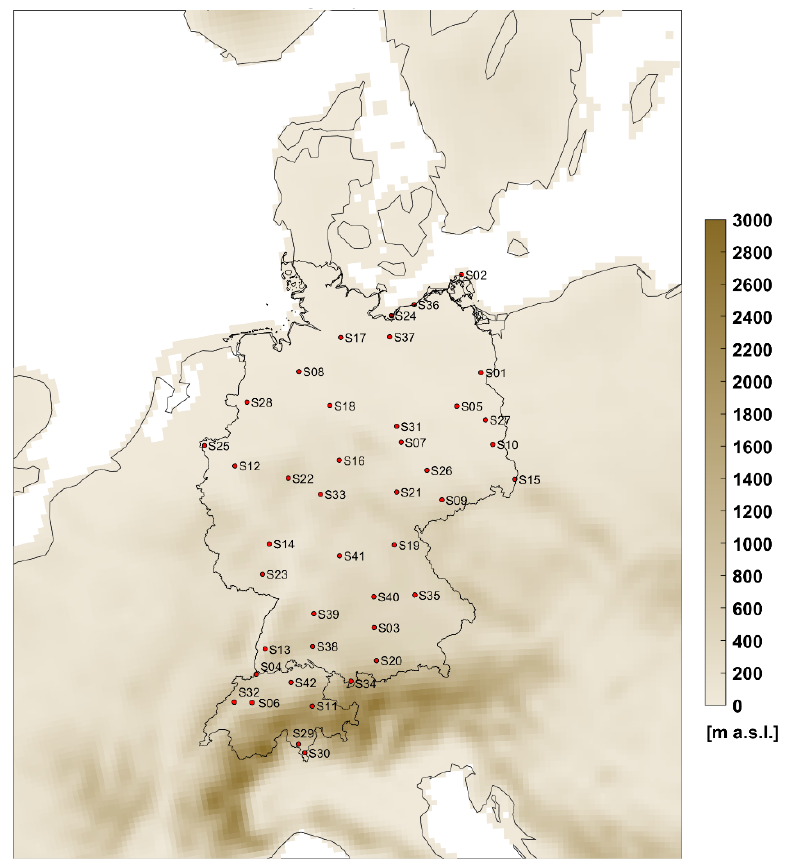
Figure 8. Elevation map and geographical locations of the 42 weather stations in Table 3.